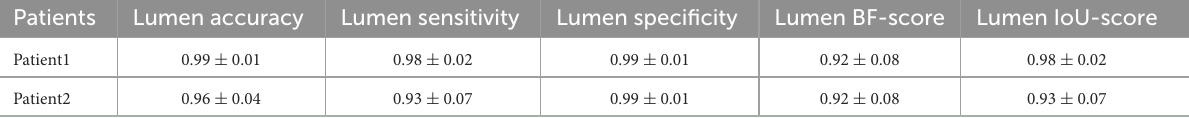
TABLE 5 Measured accuracy, sensitivity, specificity, BF-score, and IoU-score for lumen detection in CT images of the two challenging cases.